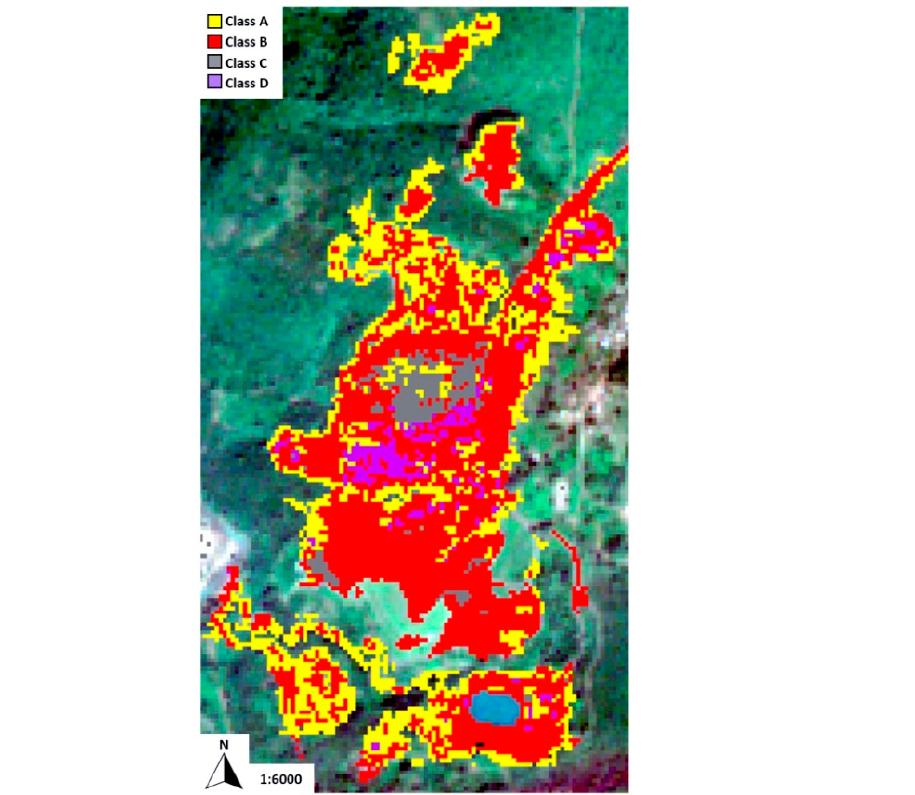
Figure 7. Map of mining residues deposits in the Fe and Mn Joda West mine.